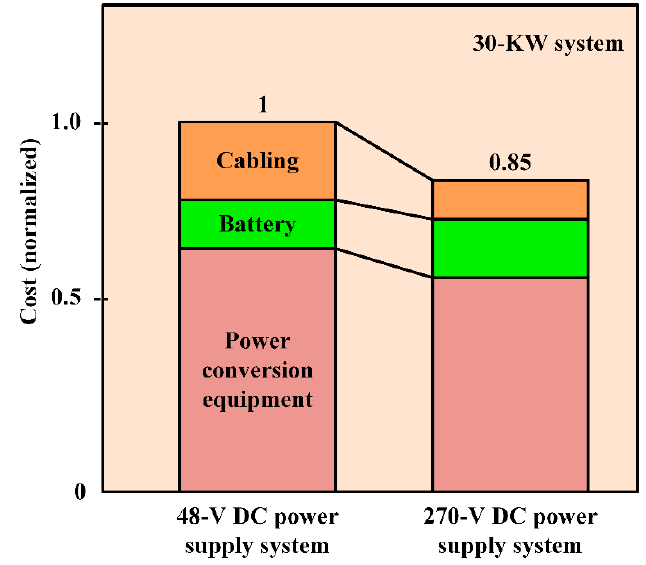
Figure 8. Cost breakdown of 48 Vdc and 270 Vdc systems.